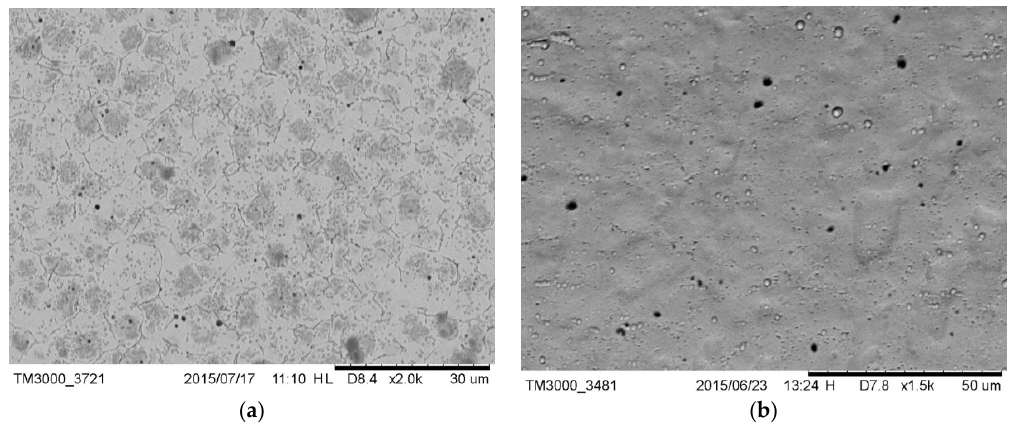
Figure 5. ( a ) Microstructure of drill D; fine dispersed carbides were visible; ( b ) external surface of drill D; some residual porosity was visible.